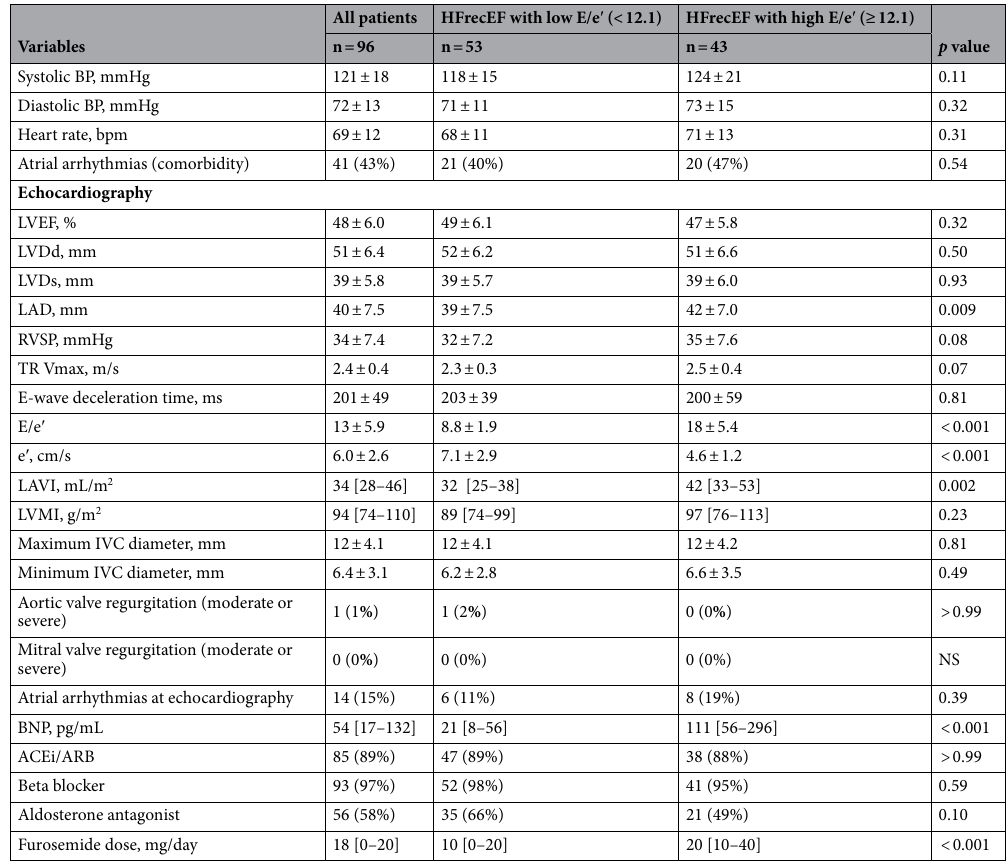
Table 2. Patients’ characteristics and echocardiography data at the 1-year follow-up. ACEi angiotensin converting enzyme inhibitor, ARB angiotensin receptor blocker, BNP brain natriuretic peptide, BP blood